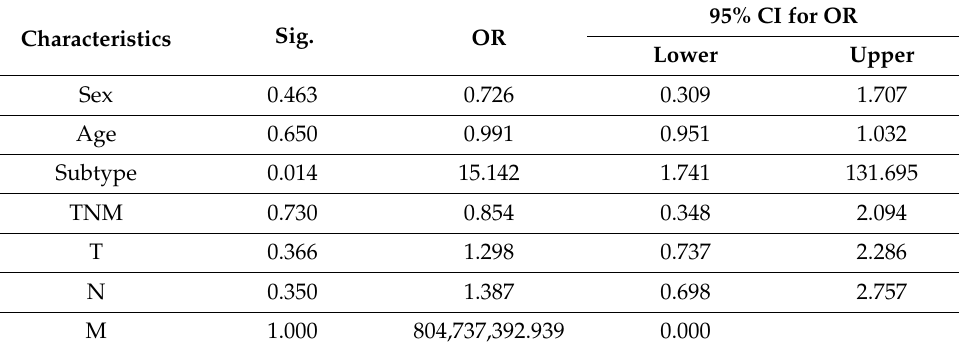
Table 3. Associations between patient characteristics and EBV status.